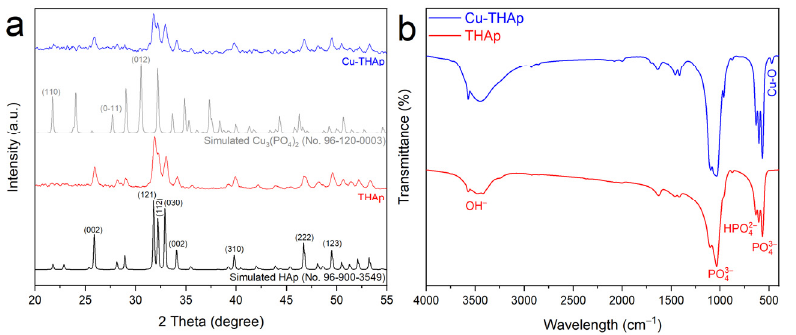
Figure 2. ( a ) XRD patterns and ( b ) FTIR spectrums of samples.